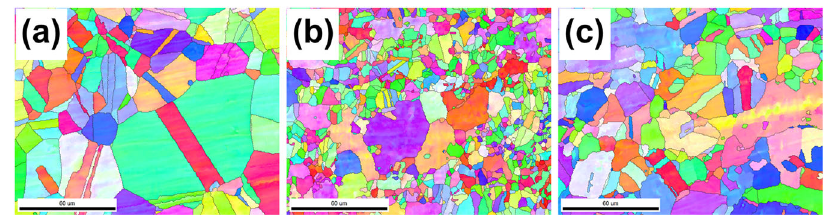
Fig. 14 EBSD images of three stainless steels. a 316L SS, b 2205 DSS, c 2507